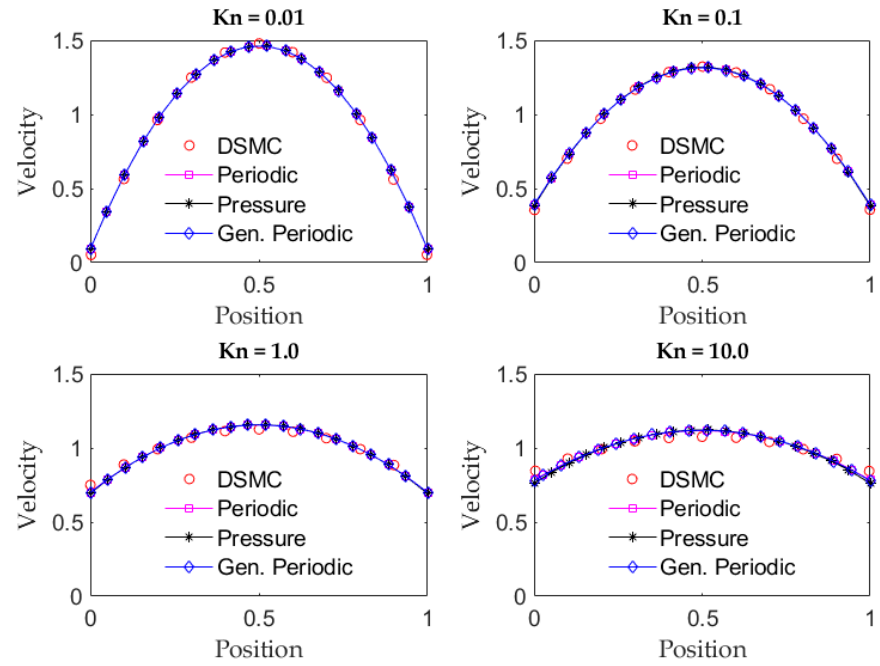
Figure 6. Velocity profiles using three inlet–outlet treatments at different Kn. Y axes represent normalized streamwise velocity, and X axes represent the position across the channel.